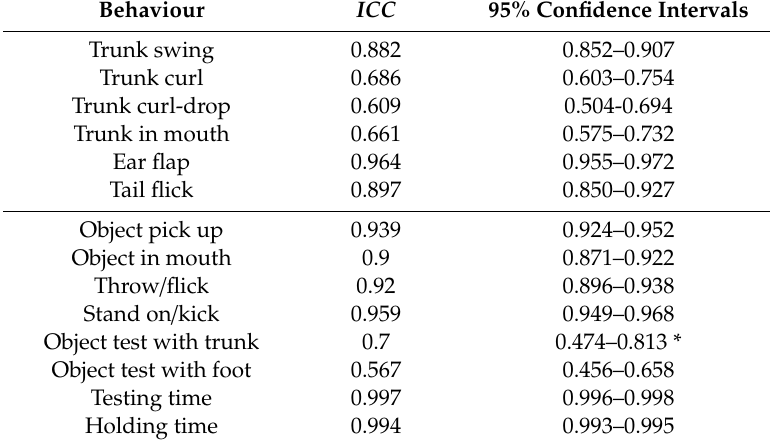
Table 2. Inter-observer reliability and 95% confidence intervals for ethogram behaviours. General behaviours (Table 1a) above the dotted line and object-directed behaviours (Table 1b) below.